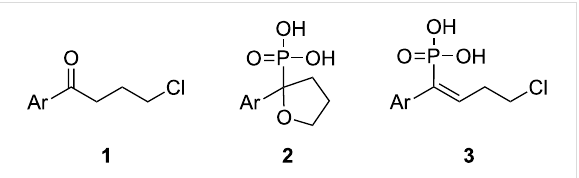
Figure 1: Treatment of 4-chloro-1-aryl-1-butanones 1 with PCl 3 /AcOH lead to unexpected cyclic product 2 instead of the expected alkene 3